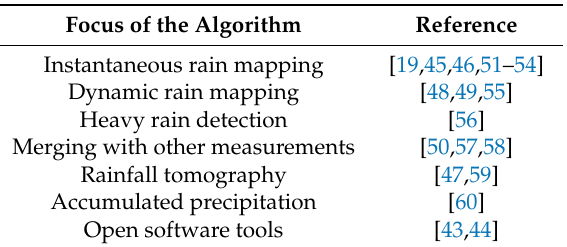
Table 4. Algorithms and tools.